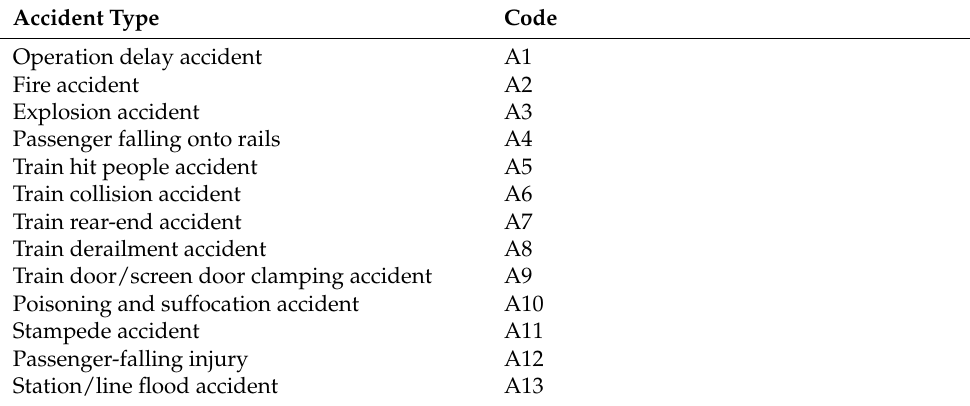
Table 1. Accident type and corresponding